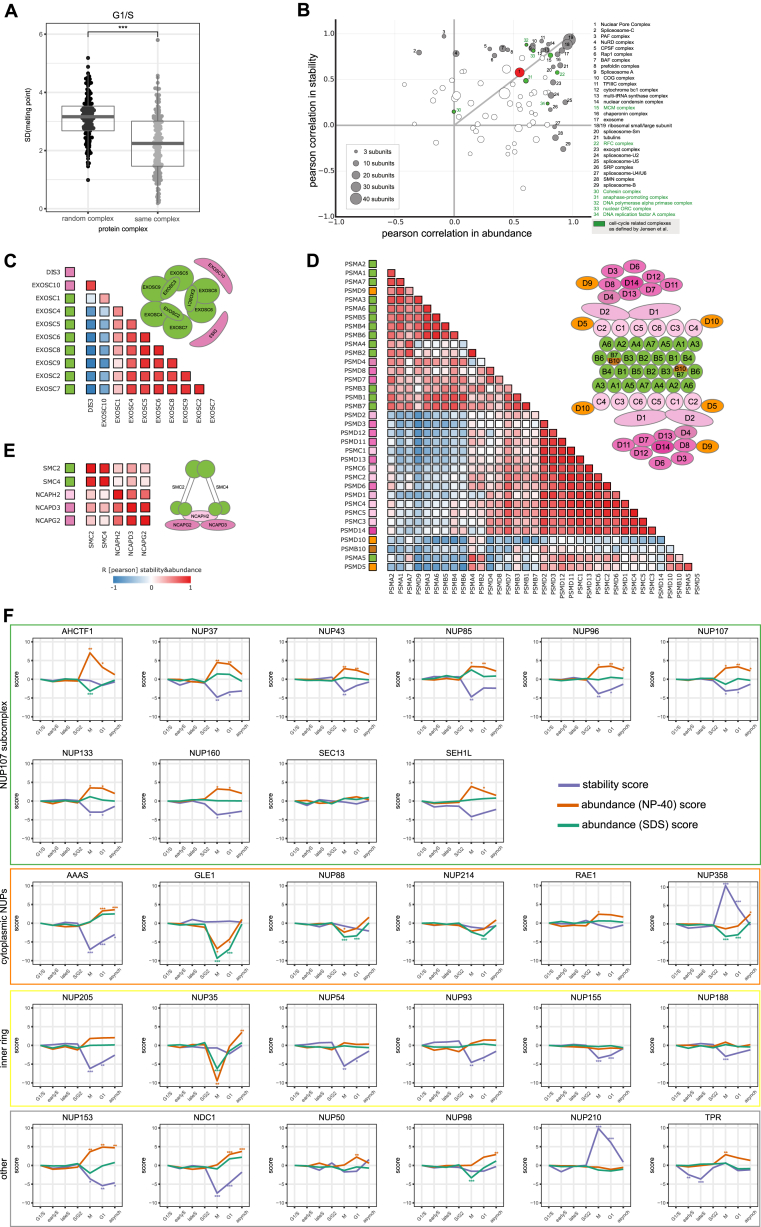
Overview of Complex Co-stability and Co-abundance and Differential Stability Pattern of Moonlighting Subunits of the Exosome Complex, Related to Figure 5(A) Melting temperatures of same protein complexes in G1/S compared to random complex assignment.(B) Scatterplot showing complex median co-abundance (median correlation calculated from abundance profiles of corresponding subunits) versus complex median co-stability (median correlation calculated from stability profiles of corresponding subunits).(C) Exosome structure with indicated catalytic subunits, DIS3 and EXOSC10 (light red). Density graph of correlation values (Pearson) calculated from concatenated abundance-stability profiles of all subunits of the Exosome complex, as well as the corresponding correlation matrix as designed for the NPC (see Figure 6F).(D) Correlation matrix of proteasome-subunits based on their concatenated abundance-stability profiles. The colors on the left indicate their association with a specific sub-structure of the proteasome, as colored in the respective cartoon.(E) Correlation matrix of condensin II-subunits based on their concatenated abundance-stability profiles. The colors on the left indicate their association with a specific sub-structure of condensin II, as colored in the respective cartoon.(F) Line plots for all measured subunits of the NPC-complex showing stability (purple), abundance (NP-40, orange) and abundance (SDS, green) scores.